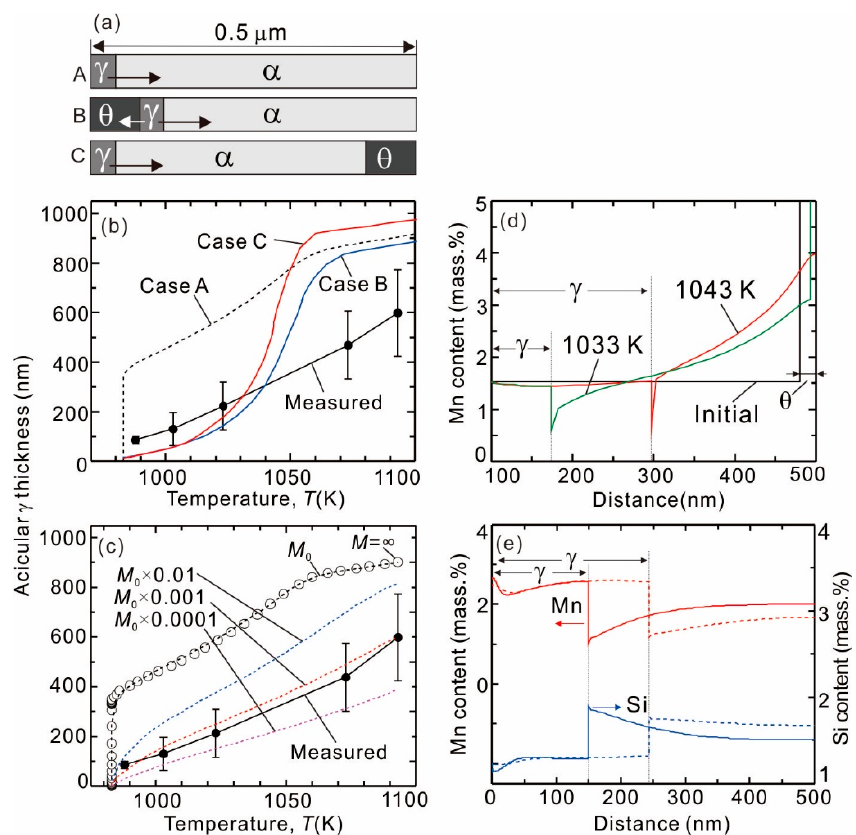
Figure 5. ( a ) Three different geometries for the simulation of γ reversion. Comparisons between measured and simulated thickening kinetics of acicular γ in cases ( b ) A, B, C with infinite interface mobility, and ( c ) case A with different interface mobilities. ( d ) Concentration profiles of Mn at different temperatures in case ( c ). ( e ) Concentration profiles of Mn and Si in the early stage of reversion at 1073 K at interface mobility of 0.001 M 0 .